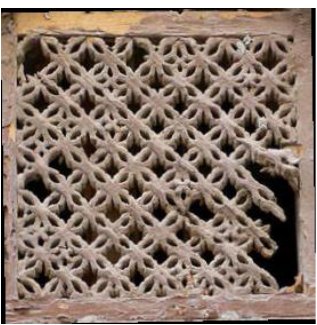
Figure 3. Manjurs in Jeddah houses (Source: SCTA,